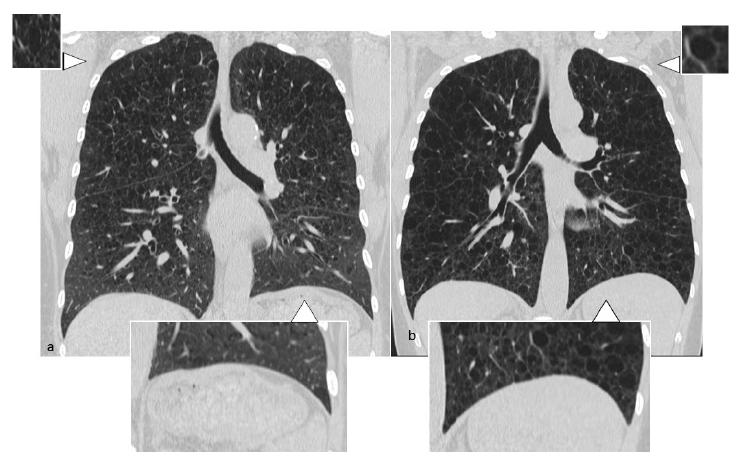
Figure 4. Di ff erential diagnosis between LCH and LAM: in LCH ( a ), cysts present bizarre shape, polilobular contours and thick walls, with sparing of costophrenic angles. In LAM ( b ), cysts are regular and rounded, uniform in size, with thin walls; they have wide distribution, including costophrenic